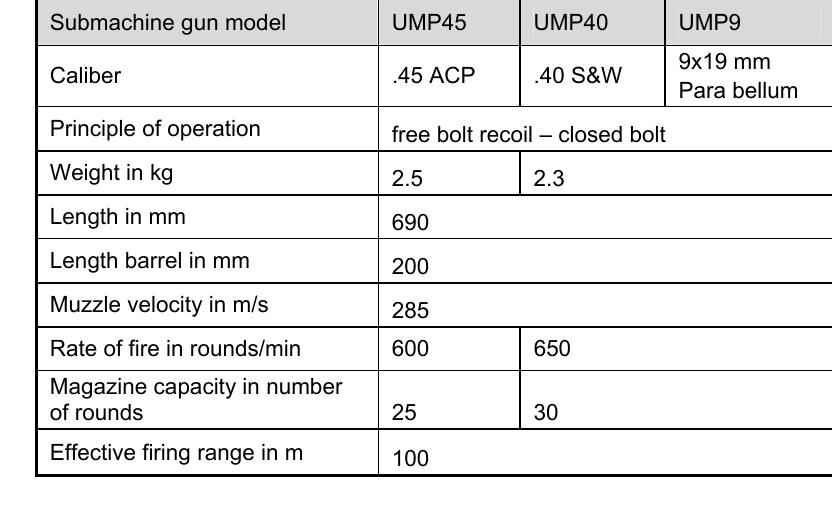
Figure 15 – H&K UMP Submachine gun Рис . 15 – Автомат H&K UMP Слика 15 – Аутомат H&K UMP Table 1 – Tactical and techical characteristics of the UMP submachine gun Таблица 1 – Тактические и технические характеристики автоматов UMP Табела 1 – Тактичко - техничке карактеристике аутомата